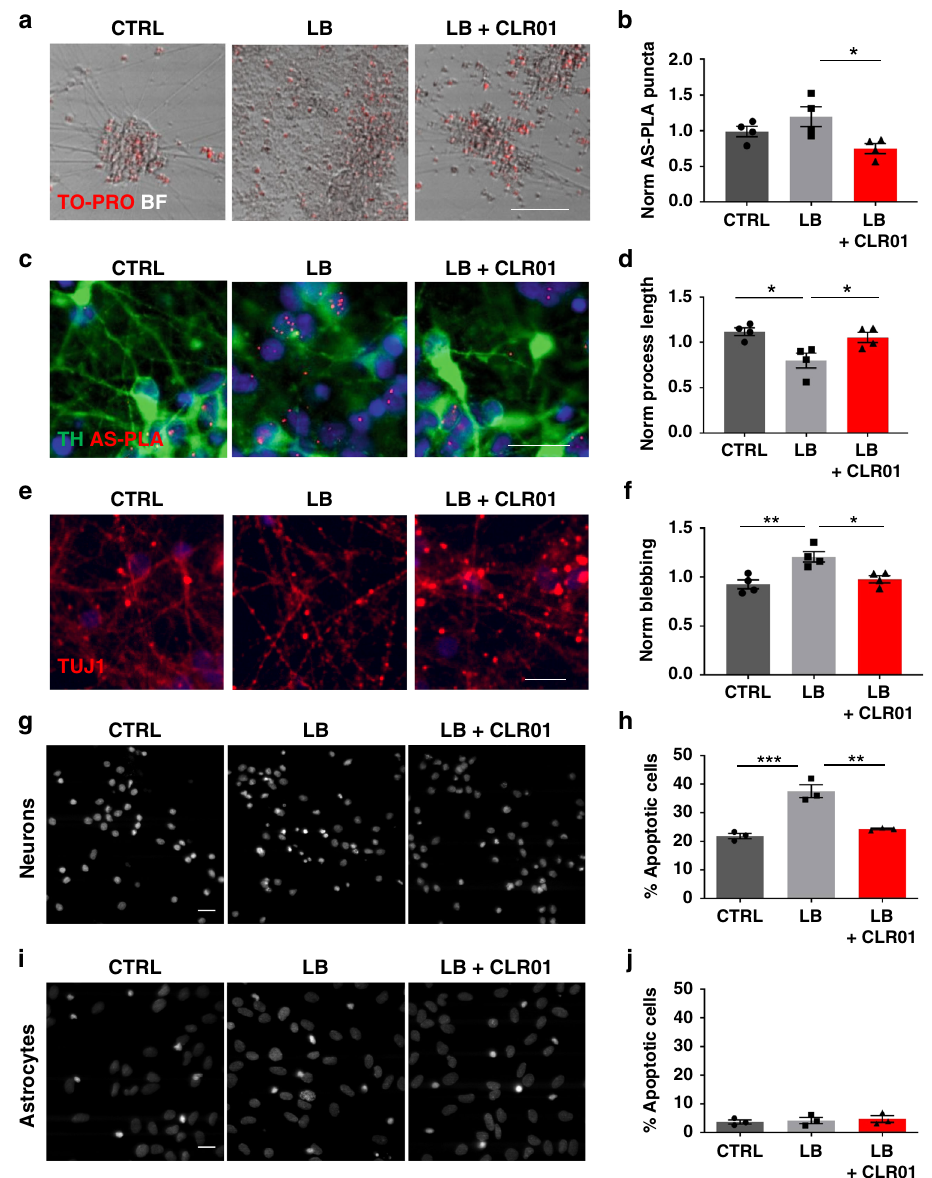
Fig. 1 CLR01 reduces α -syn aggregation and toxicity in iPSC-derived dopaminergic and primary rat cortical cultures. a , c , e Representative bright fi eld and immuno fl uorescent images of live and dead cells (labeled by To-pro), dopaminergic cells (TH-positive), AS-PLA (red puncta), and neuronal processes of four independent control cell lines analyzed. Cells were treated with LB extracts, which had been pretreated with CLR01 or PBS as a negative control. LB treatment caused an abnormal deposition of material in treated wells, accompanied by increased AS-PLA signal process degeneration, which were reduced by CLR01 pre-treatment. Scale bars = 100, 25, 25 µ m, respectively. b , d , f Quanti fi cation of indicated parameters (from c and e ) of four independent control cell lines analyzed using a one-way ANOVA (Sidak ’ s). b F(2, 9) = 5.154, p = 0.0213. d F(2, 9) = 7.309, p = 0.0112, p = 0.0356. f F(2, 9) = 10.67, p = 0.0038, p = 0.0126. g , i Representative images of neuronal (top) and astrocytic (bottom) primary rat cultures stained with DAPI ( n = 3 independent cultures and treatments). Scale bars 20 µ m. h , j Quanti fi cation of apoptotic cells (expressed as % from total) analyzed using a one-way ANOVA (Sidak ’ s, n = 3 independent cultures and treatments). k F(2, 6) = 35.09, p = 0.0005, p = 0.0012. * p < 0.05, ** p < 0.01, *** p < 0.001. For all appropriate panels, data are presented as mean values ± SEM. BF bright fi eld, Norm Supplementary Fig. 4D – F). NoLB extracts did not affect process brain extract with CLR01 (Fig. 1a and Supplementary Fig. 4A, G, length or blebbing, whereas LB extract treatment shortened I). As a next step, we evaluated the levels of α -syn oligomers in neuronal processes and increased blebbing, which was reduced by the culture and the number of tyrosine hydroxylase (TH) + cells CLR01 pre-treatment back to control levels. This indicated that (Fig. 1b – c and Supplementary Fig. 4B – C, H, J). The number of LB extract treatment caused axonal degeneration of iPSC-derived TH + cells was unchanged but we detected an upregulation of AS- dopaminergic cultures, whereas CLR01 rescued the neurons PLA puncta in LB-treated cells, which was reduced by 10 days of from these toxic effects. Finally, we exposed iPSC-derived dopa- 10 µM CLR01 pre-treatment. Finally, as axonal degeneration has minergic cultures to LB extracts pretreated with increasing been shown to precede cell death in PD 19 , we analyzed processes labeled by the Tuj1 antibody to β III-tubulin (Fig. 1d – f and concentrations of CLR01 or the inactive analog CLR03.